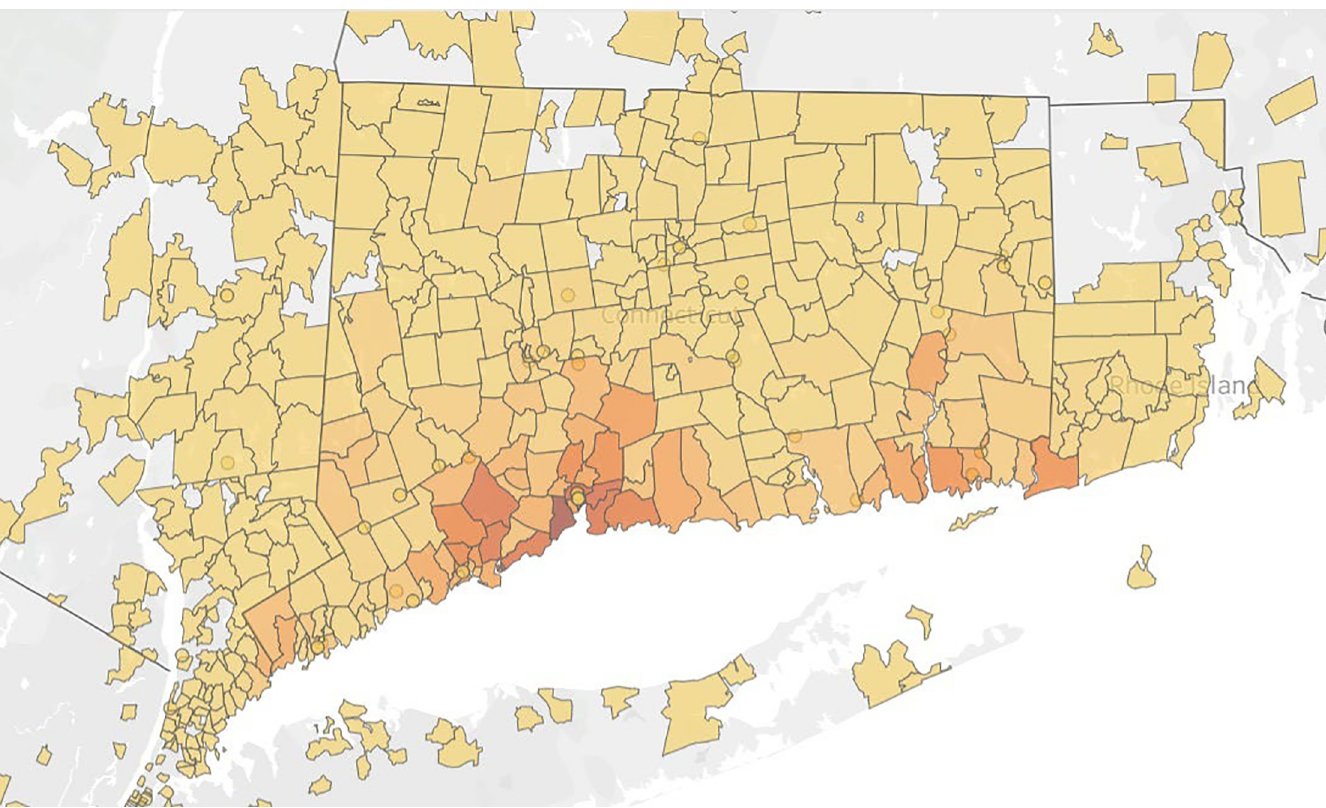
Fig 1. Population distribution of patients in the Yale Heart Failure Registry � . � Darker shading represents a greater density of patients in the registry from a zip code.